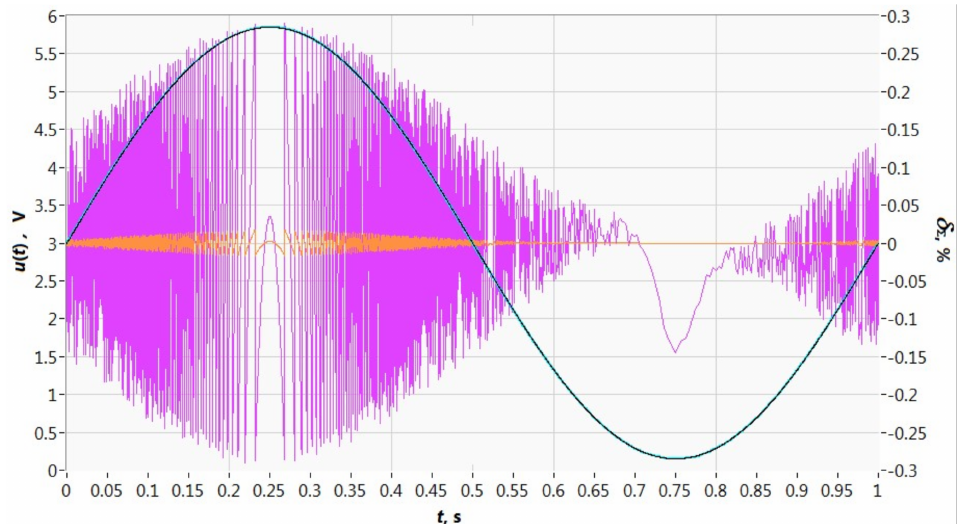
Figure 14. Results of the simulation of test signal processing by the f/N converter using the basic processing